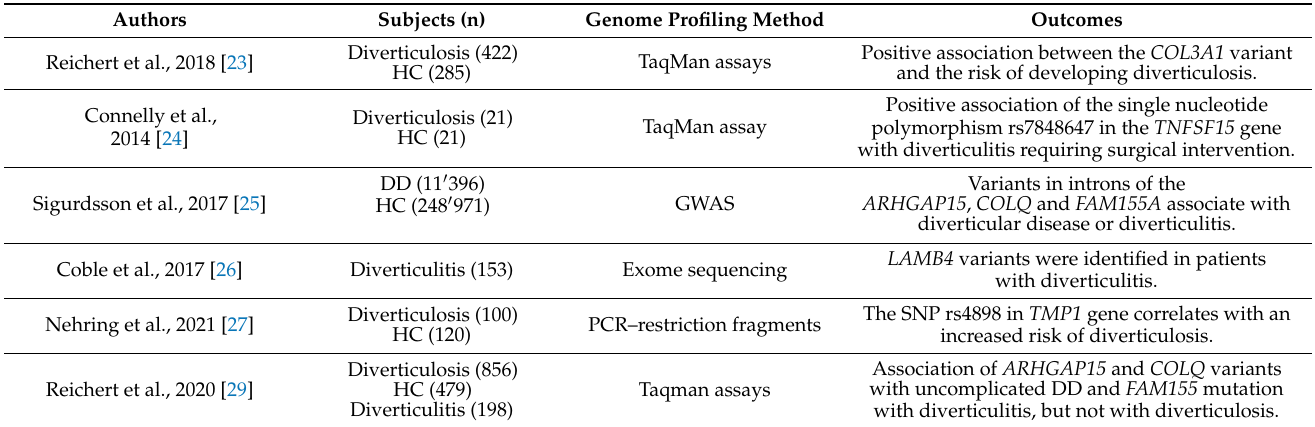
Table 1. Main studies assessing genetic variants in